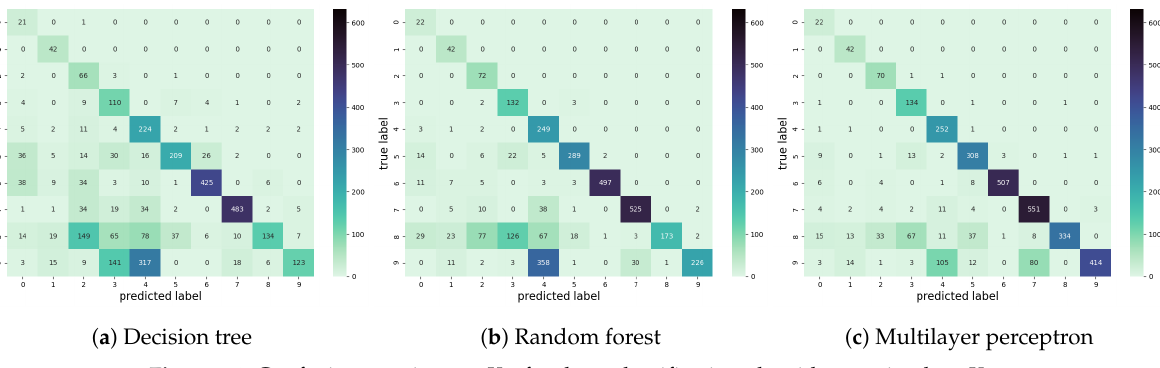
Figure 14. Confusion matrices on X b , for three classification algorithms trained on X a